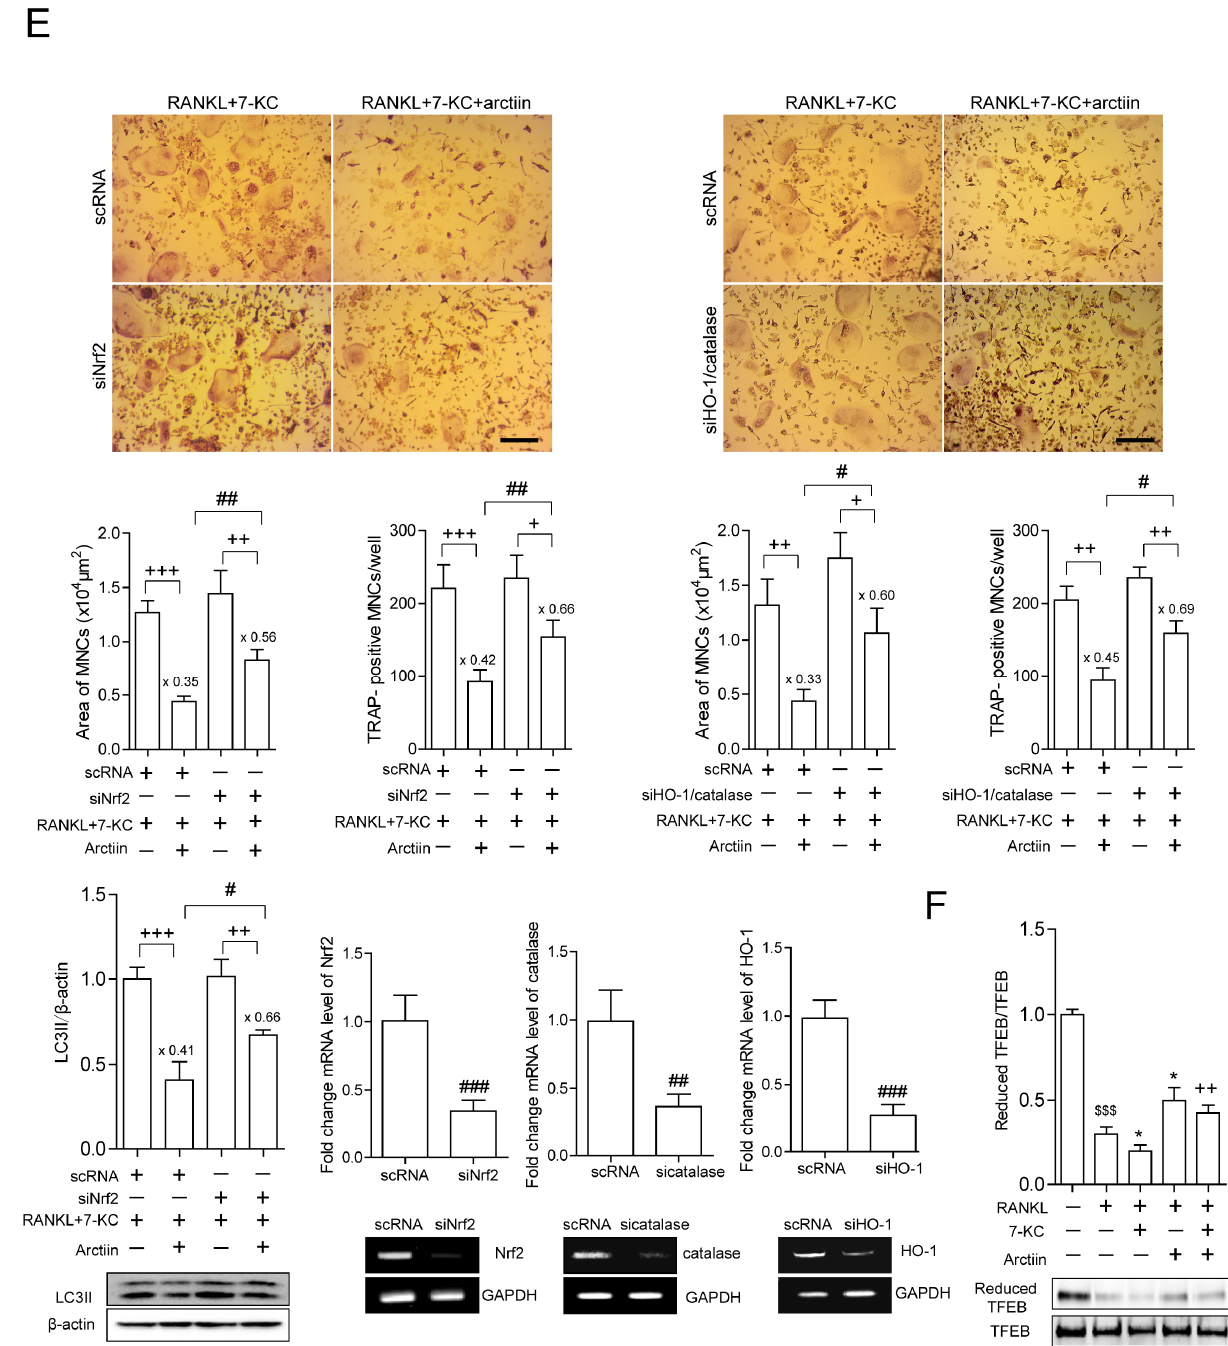
Figure 4. Arctiin decreases cytosolic ROS that is increased upon 7-KC stimulation, leading to an increase in the reduced form of TFEB. ( A ) Cytosolic ROS levels were determined by flow cytometry using H 2 DCFDA after 48 h with arctiin (10, 15, 20 µ M) ( n ≥ 3). ( B , C ) BMMs were incubated with M-CSF (30 ng/mL) and RANKL (40 ng/mL) in the presence or absence of 7-KC (7 µ M) or arctiin (15 µ M) ± DPI (5 nM) or NAC (3 mM) for 65 h ( n = 3). ( B ) The cells were then fixed, TRAP-positive MNCs and the OC area were analyzed. ( C ) The levels of LC3II were analyzed in the cell lysates. BafA1 (25 nM) was added 4 h before harvesting to stimulate the accumulation of LC3II. The expression